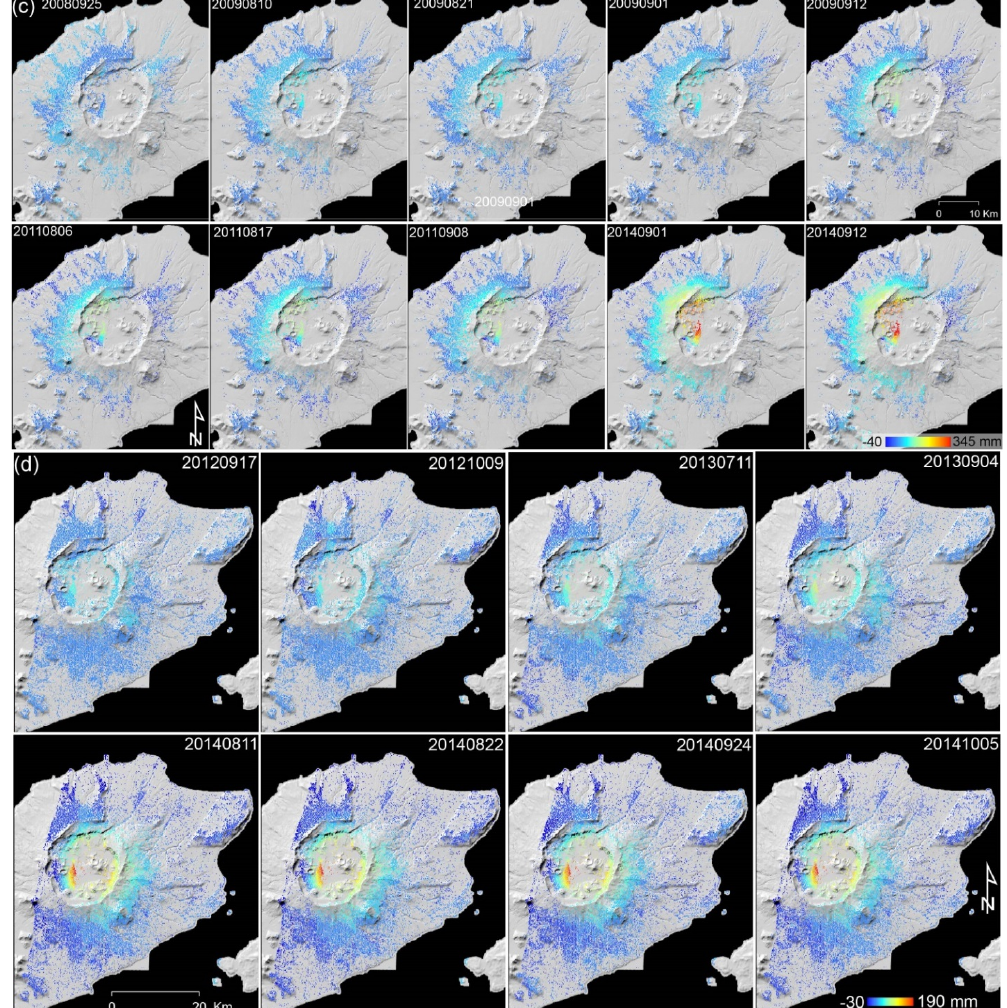
Figure 6. Cumulative deformation maps for each InSAR dataset: ( a ) Envisat track 222, ( b ) Envisat track 115, ( c ) TerraSAR-X track 93, ( d ) TerraSAR-X track 116, all referenced temporally to the earliest scene for each (20090623 for E222, 20081029 for E222, 20080914 for T93, and 20110727 for T116). The cold colors (blue to yellow) represent LOS subsidence ( i.e. , incremental displacement away from the satellite) to small LOS uplift ( i.e. , displacement towards the satellite), and the hot-colored points show large LOS